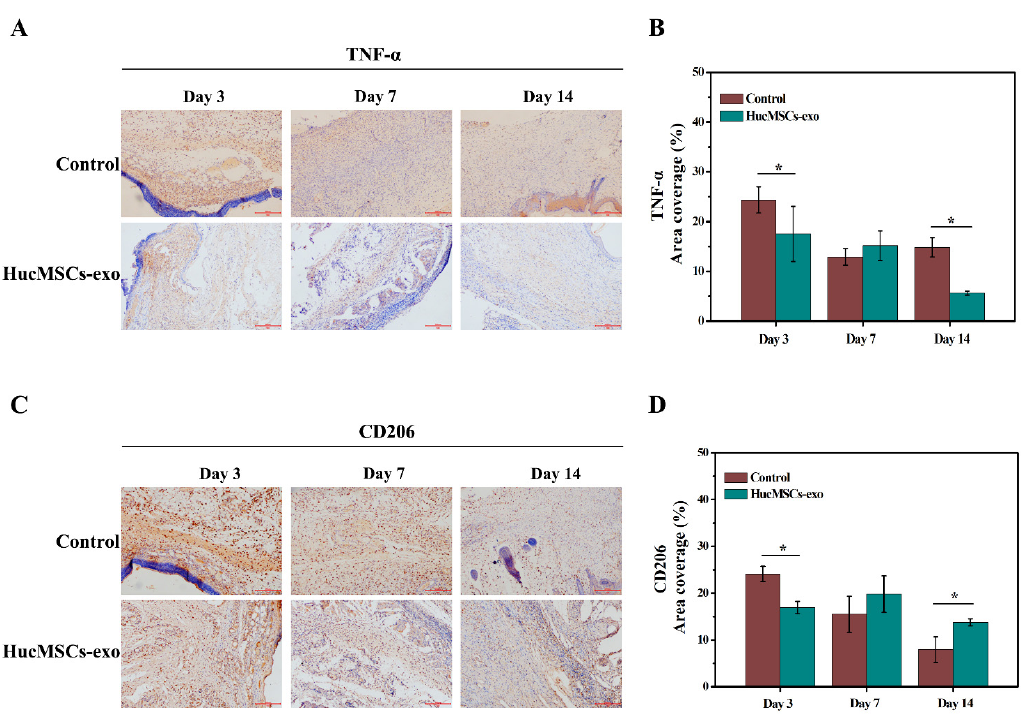
Figure 5. Immunohistochemistry analysis of TNF- α and CD206 expression in diabetic wound tissues on days 3, 7, and 14. Representative images of TNF- α ( A ) and CD206 ( C ) staining of wound tissues. The scale bar is 200 µ m. Quantitative analysis of the positively stained area percentage of TNF- α ( B ) and CD206 ( D ). The data are expressed as mean ± SD (n = 3). * p < 0.05 compared with the control group.